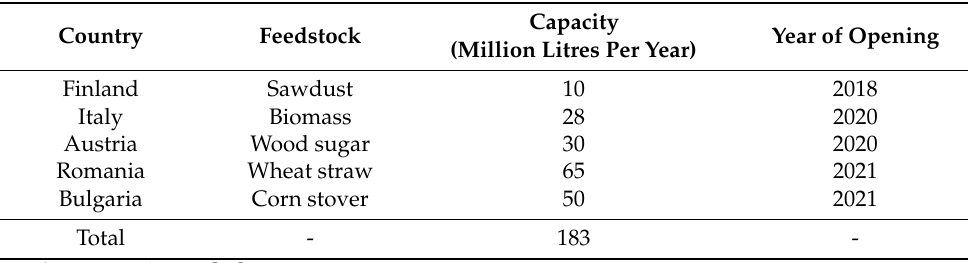
Based on: EU FAS Posts